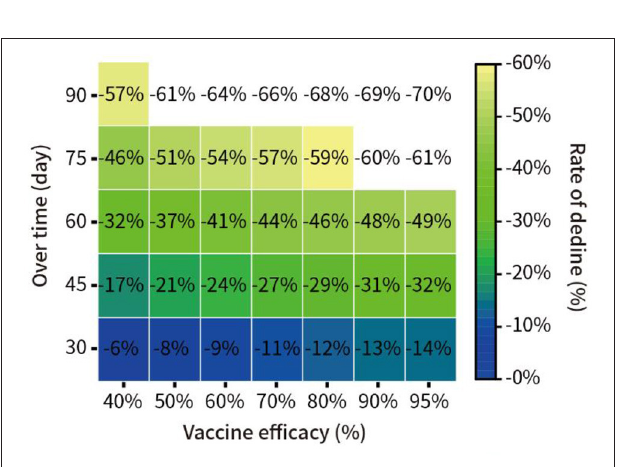
FIGURE 6 | Prediction of the spread of the pandemic under vaccination with different potency in New York.